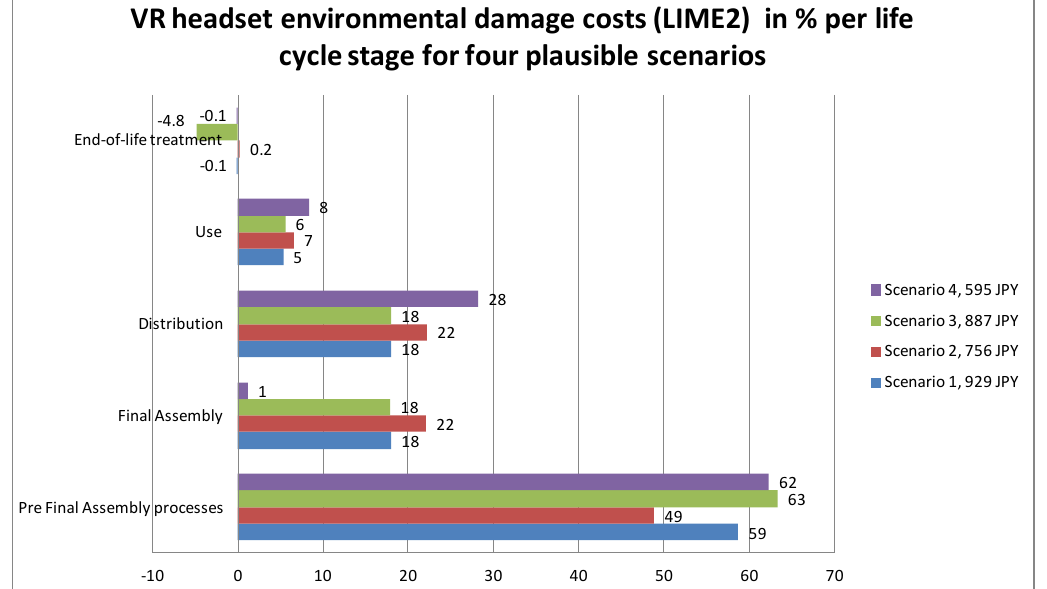
Figure 4. Screening LCA results (LIME2) for the VR headset for Scenarios 1–4.